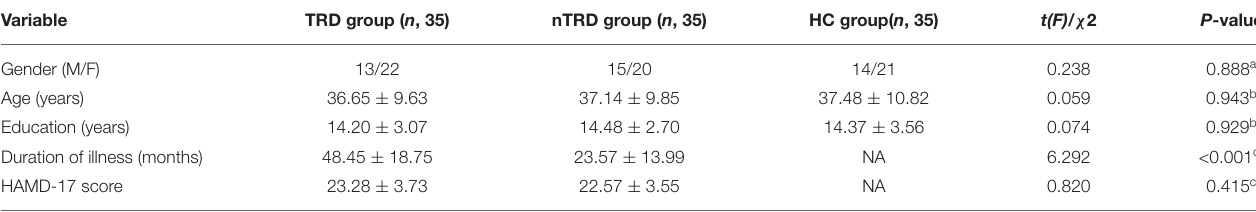
TABLE 1 | Demographic and clinical characteristics of the study participants. Variable